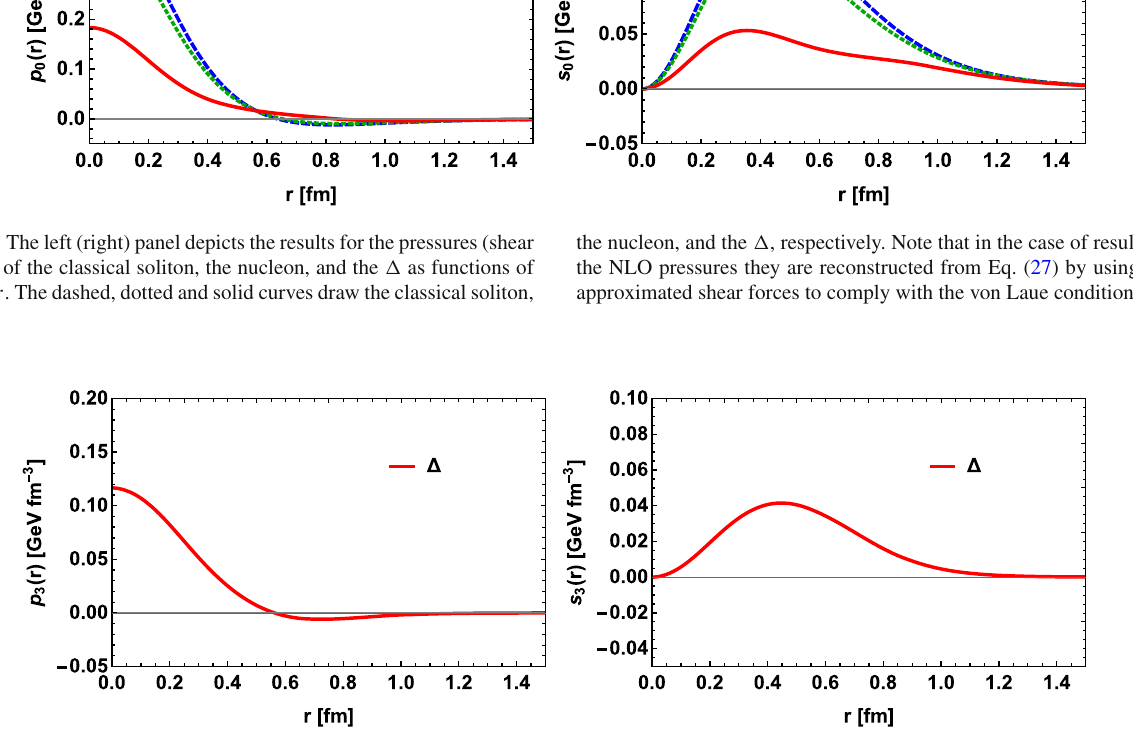
Fig. 4 The left (right) panel depicts the results for the quadrupole pressures (shear forces) of the (cid:2) as a function of radius r . The quadrupole pressure density p 3 ( r ) is reconstructed from Eq. (27) by using the approximated quadrupole shear force density s 3 ( r ) in order to comply with the von Laue condition